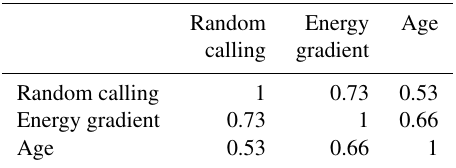
Table 4. Correlation coefficient among scheduling methods for Layer